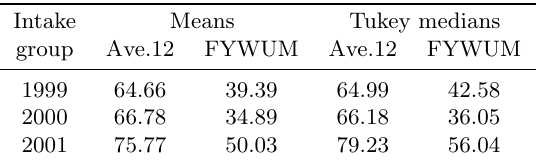
Table 3: Means and Tukey medians of Ave.12 and FYWUM for 1999, 2000 and